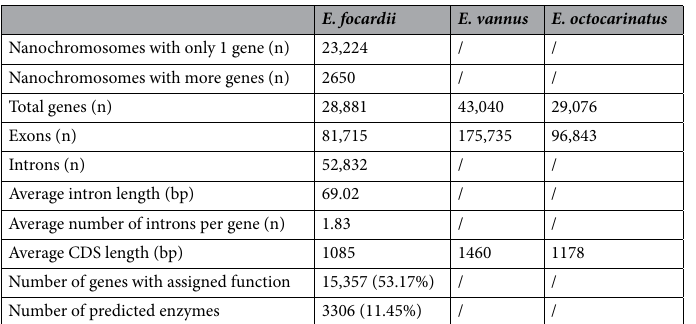
Table 2. E. focardii Gene prediction features in comparison with E. vannus 79 and E. octocarinatus 38